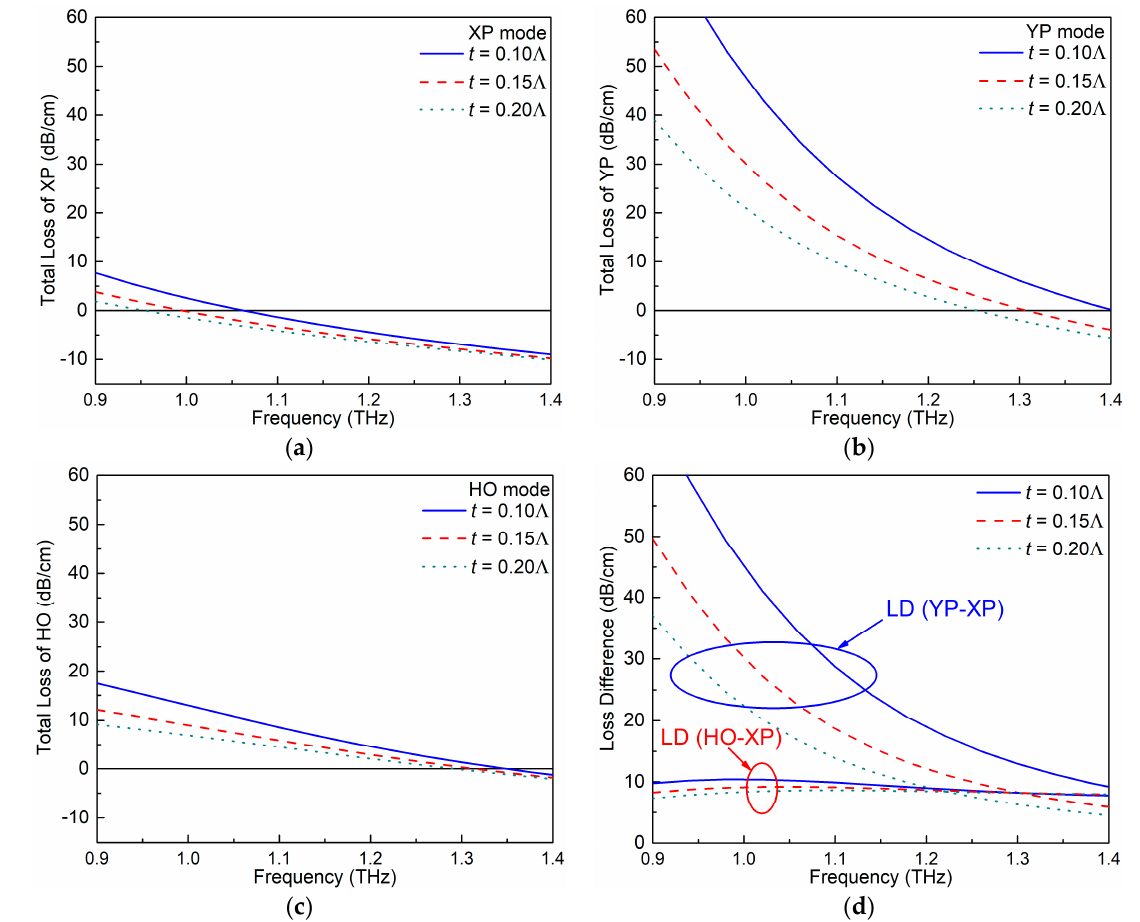
Figure 5. The TL values of the ( a ) XP, ( b ) YP, and ( c ) HO modes of the active ENZ-based PCF as functions of the frequency for different ENZ ring thicknesses ( t ). ( d ) The corresponding LD values between the wanted and unwanted modes.